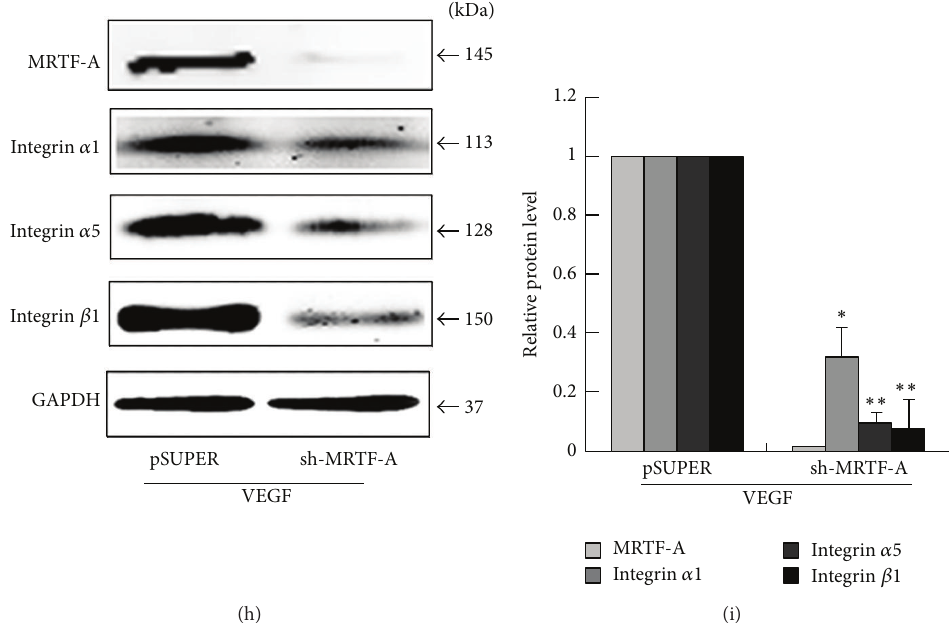
Figure 2: MRTF-A is essential for the VEGF-induced angiogenesis of differentiated MSCs and integrin 𝛼 1, 𝛼 5, and 𝛽 1 expression. (a) After transfection with sh-MRTF-A or pSUPER (control), MSCs were cultured with EC differentiation medium for 3 d. MTT assay was performed to test the viability of MSCs. (b and c) MSCs were differentiated into ECs by treatment with VEGF for 7d and siRNA-mediated knockdown experiments were then performed in the MSCs-derived ECs. The migratory ability of MSC-derived ECs transfected with si-MRTF-A or control siRNA was determined via wound healing (b) and transwell chamber assays (c). (d) Cell migration was quantified by calculating relative cell numbers. ∗∗ 𝑃 < 0.01 , 𝑛 = 3 . (e) After differentiation and siRNA or shRNA-mediated knockdown, the cells were cultured in matrigel for 7 d. Morphological changes in differentiated cells transfected with siMRTF-A or sh-MRTF-A were observed. (f) Capillary-like structures were quantified by measuring the polygonal network. ∗∗ 𝑃 < 0.01 , 𝑛 = 3 . (g) The expression of integrins 𝛼 1, 𝛼 5, and 𝛽 1 was estimated by qPCR. ∗ 𝑃 < 0.05 ; ∗∗ 𝑃 < 0.01 , 𝑛 = 3 . (h) The expression of integrins 𝛼 1, 𝛼 5 and 𝛽 1 was estimated by western blot. (i) The relative quantification of the protein expression. ∗ 𝑃 < 0.05 ; ∗∗ 𝑃 < 0.01 , 𝑛 = 3